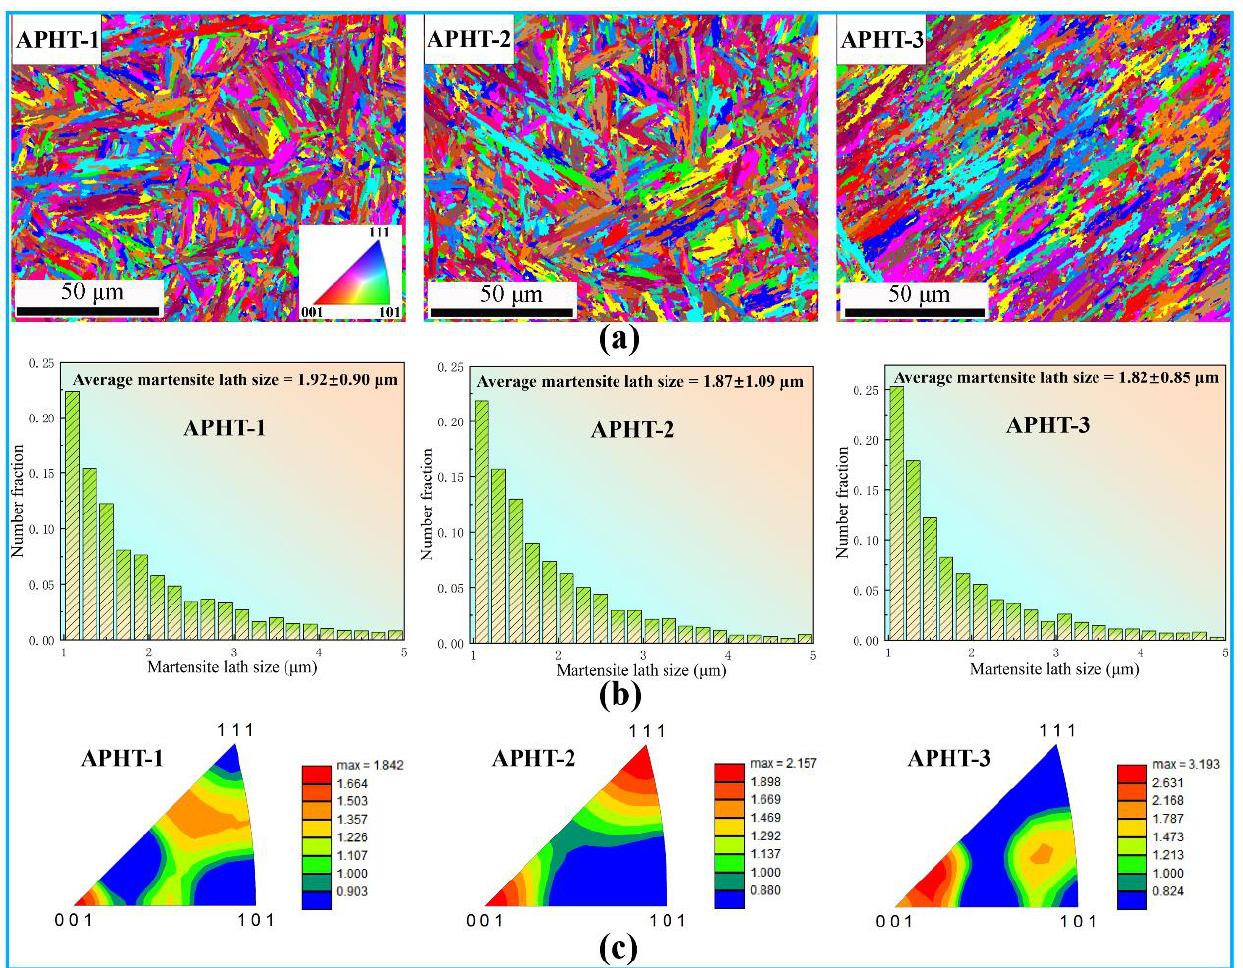
Figure 5. EBSD images of three samples: ( a ) inverse pole figure maps; ( b ) martensite lath size number fraction; ( c ) inverse pole figure.